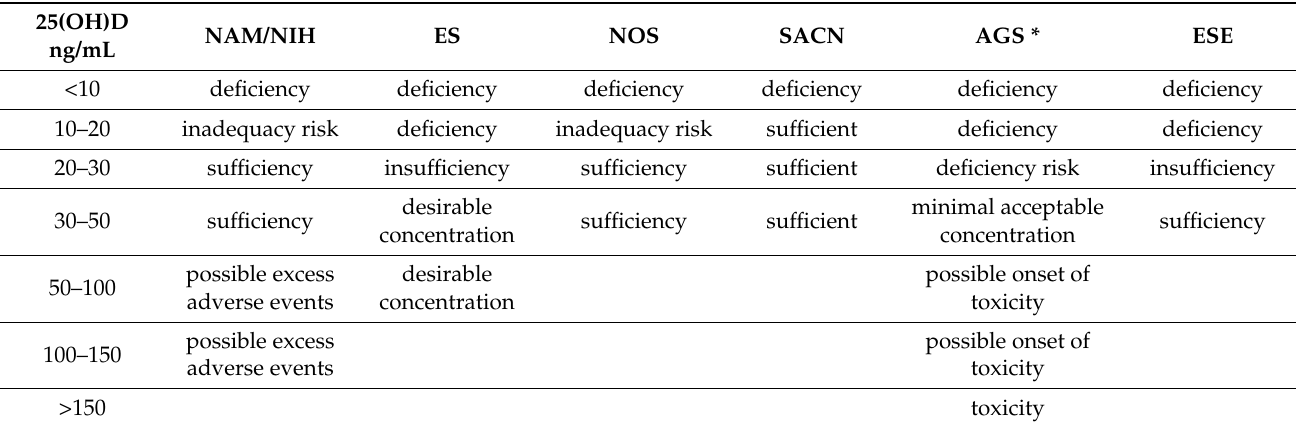
Table 4. Diverse thresholds of serum vitamin D [25(OH)D] for the definition of sufficiency, insufficiency, or deficiency proposed by diverse scientific societies and international